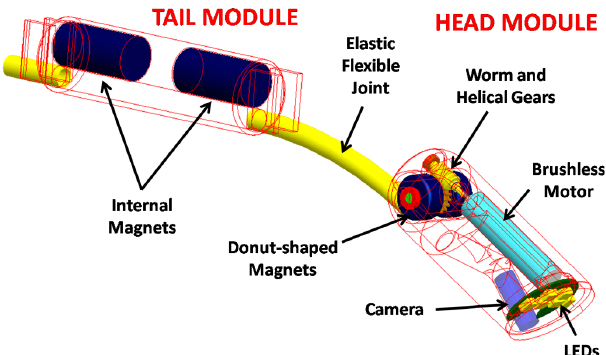
Figure 5. Threedimensional model of the designed prototype. The head module embeds ring magnets, a motor with gears and a vision system; the tail module embeds only two magnets for the system anchoring and external rough motion. The device results 12.7mm in diameter and 95mm in